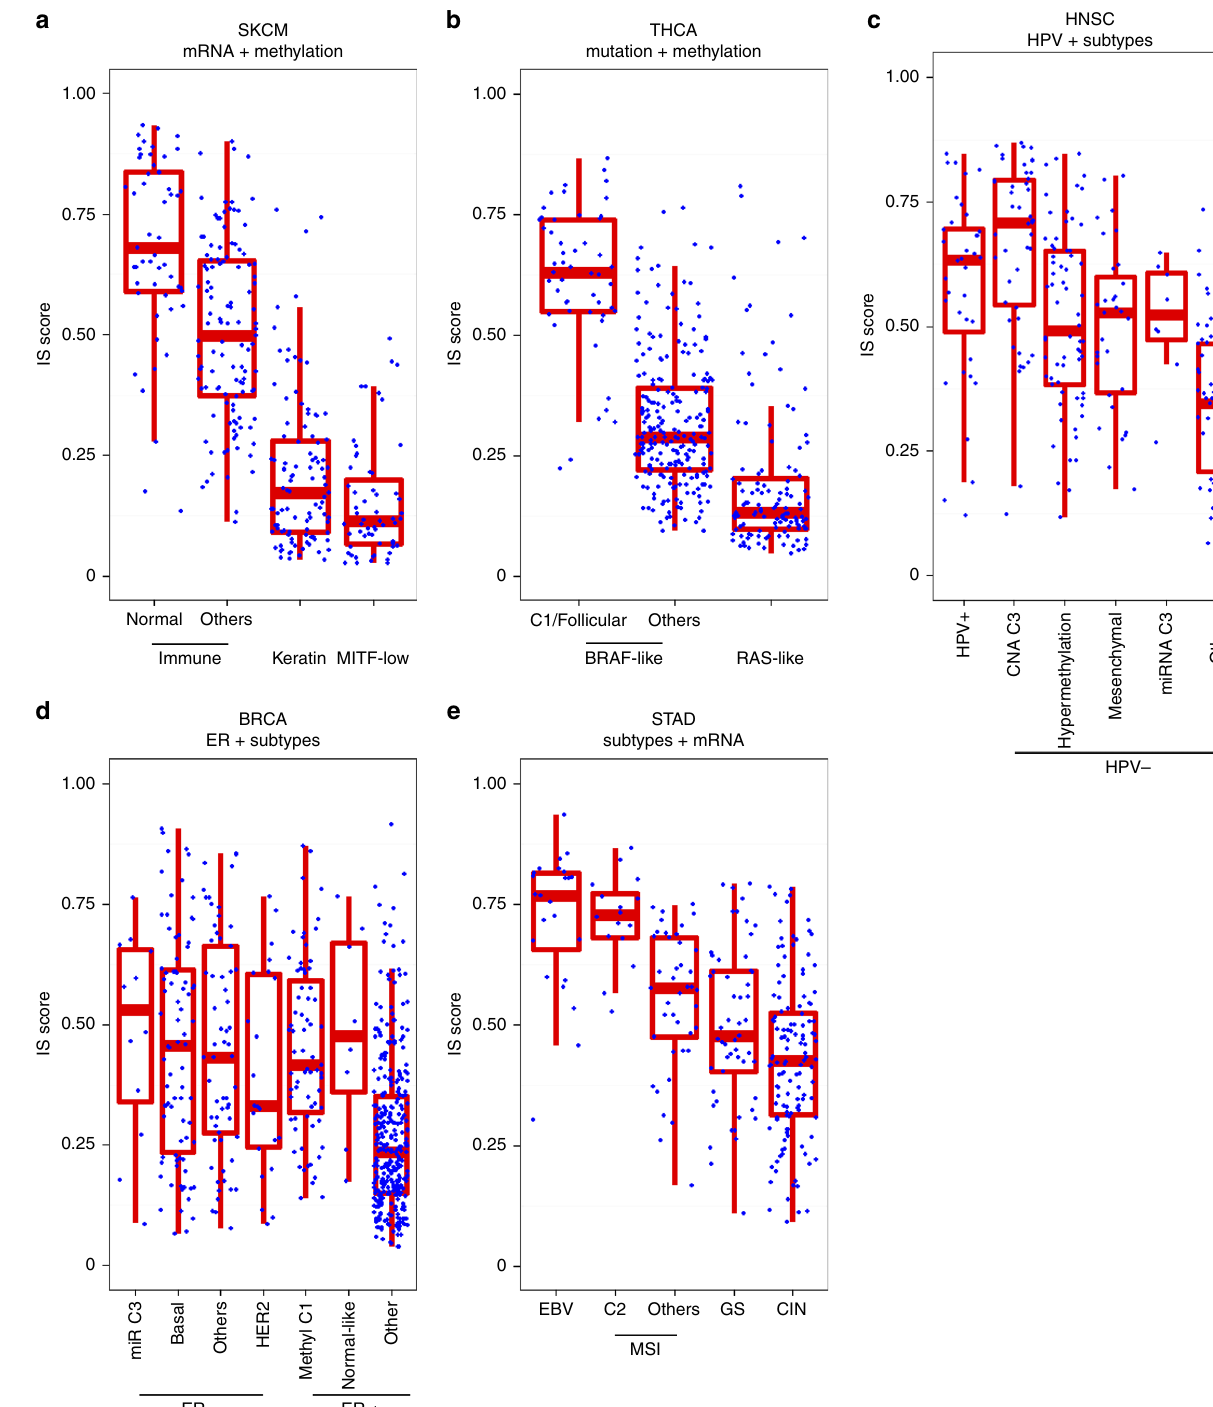
Fig. 3 Molecular subtypes of cancers associated with potential response to immunotherapy. a Melanoma tumors were grouped according to mRNA subtypes fi rst and immune-high subtype was further strati fi ed by methylation subtypes (Normal-like or others). b Thyroid tumors were grouped according to mutation subtypes fi rst and BRAF-like subtype was further strati fi ed by methylation subtypes (C1/Follicular or Others). c Head and neck squamous cell carcinoma tumors were grouped by HPV-infection status fi rst and HPV-negative tumors were further strati fi ed by molecular subtypes. d Breast tumors were grouped by ER status fi rst and tumors were further strati fi ed by molecular subtypes. e Stomach tumors were grouped by molecular subtypes fi rst and MSI tumors were further strati fi ed by mRNA subtype (C2 or others). Blue dot represents IS score, and red lines in the box represent upper 75%, median, and lower 25% values of molecular subtype. See also Supplementary Figs. 12 −